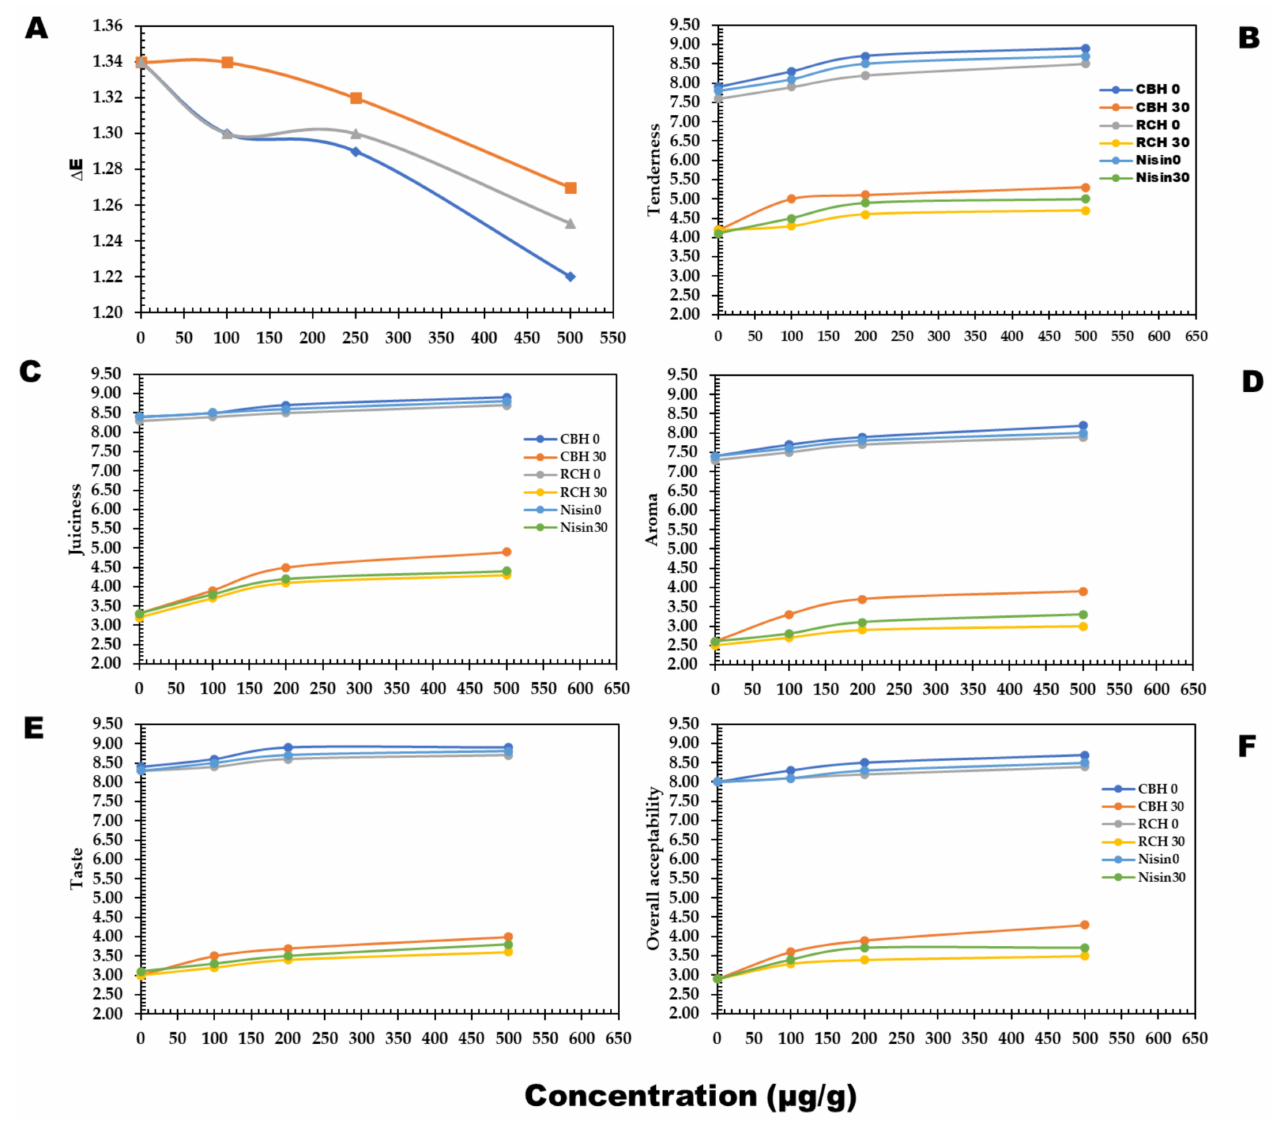
Figure 4. The changes in sensorial quality of buffalo meat steak supplemented with CBH and RCH (100, 250, and 500 µ g/g) and nisin 500 µ g/g persevered at 4 ◦ C during 0–30 days storage. The sensorial parameters; Color ( A ), Tenderness ( B ), Juiciness ( C ), Aroma ( D ), Taste ( E ), and Overall Acceptability ( F